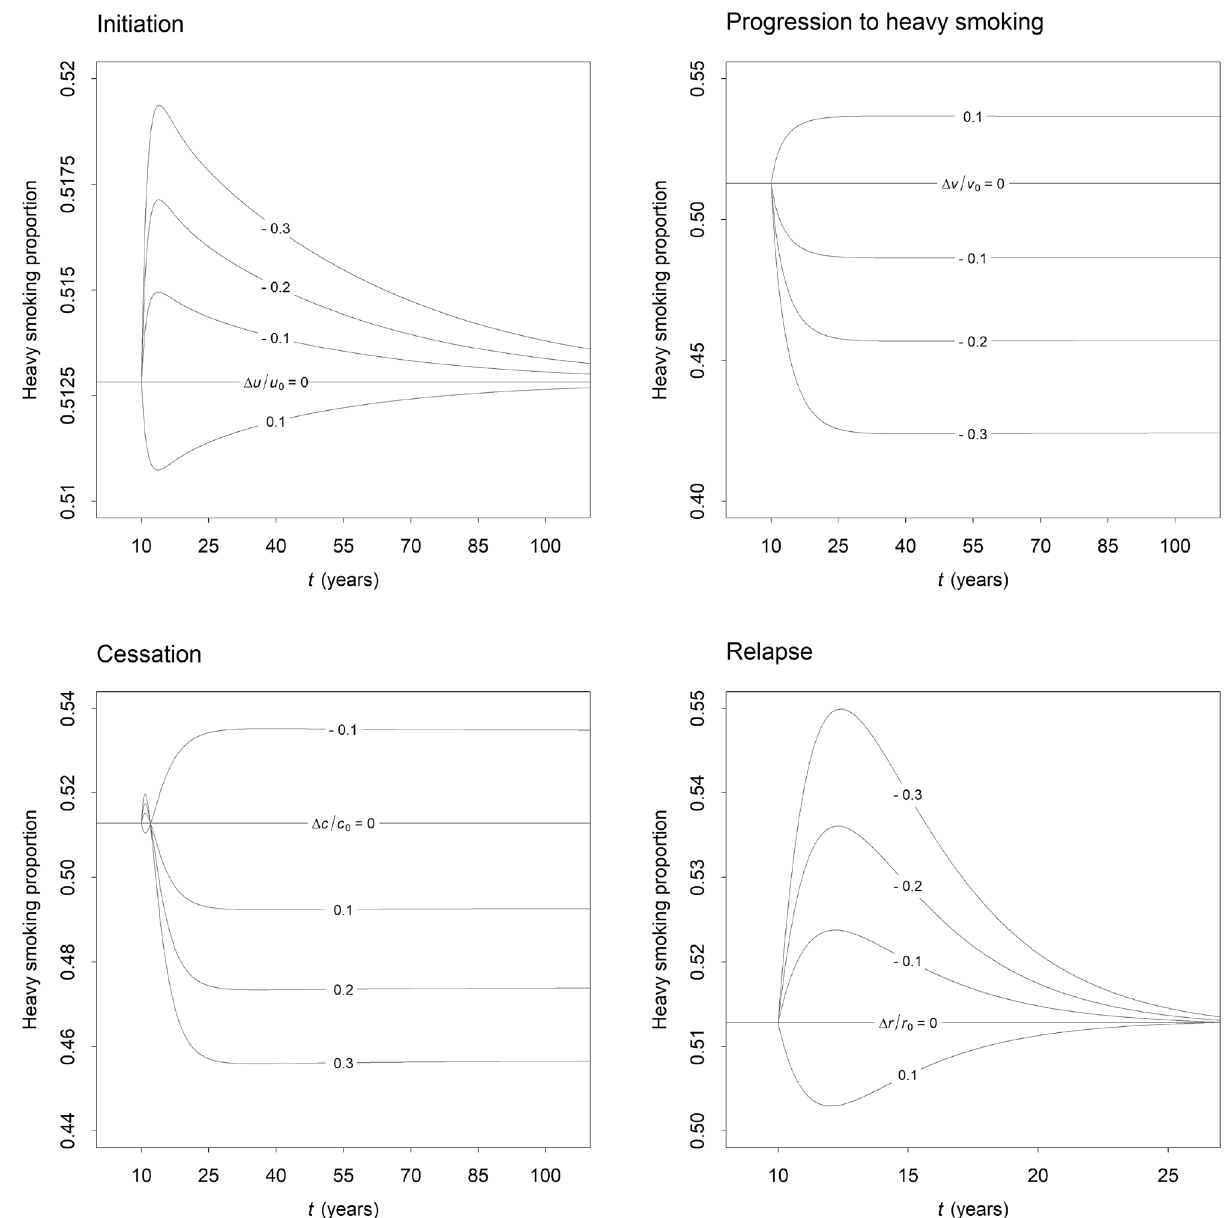
Figure 2. Effects of changes in per capita rates of smoking behaviour change on the proportion of smokers who are heavily dependent. All rate changes were instantaneous and sustained (starting at t = 10 ). Per capita rates of initiation, progression to heavily dependent smoking, and relapse ( u , v , and r , respectively) were reduced by 10%, 20%, and 30% of their initial values ( u 0 , v 0 , and r 0 ), and increased by 10% of their initial values; the per capita cessation rate for less dependent smokers, c , was increased by 10%, 20%, and 30% of its initial value ( c 0 ) and reduced by 10% of its initial